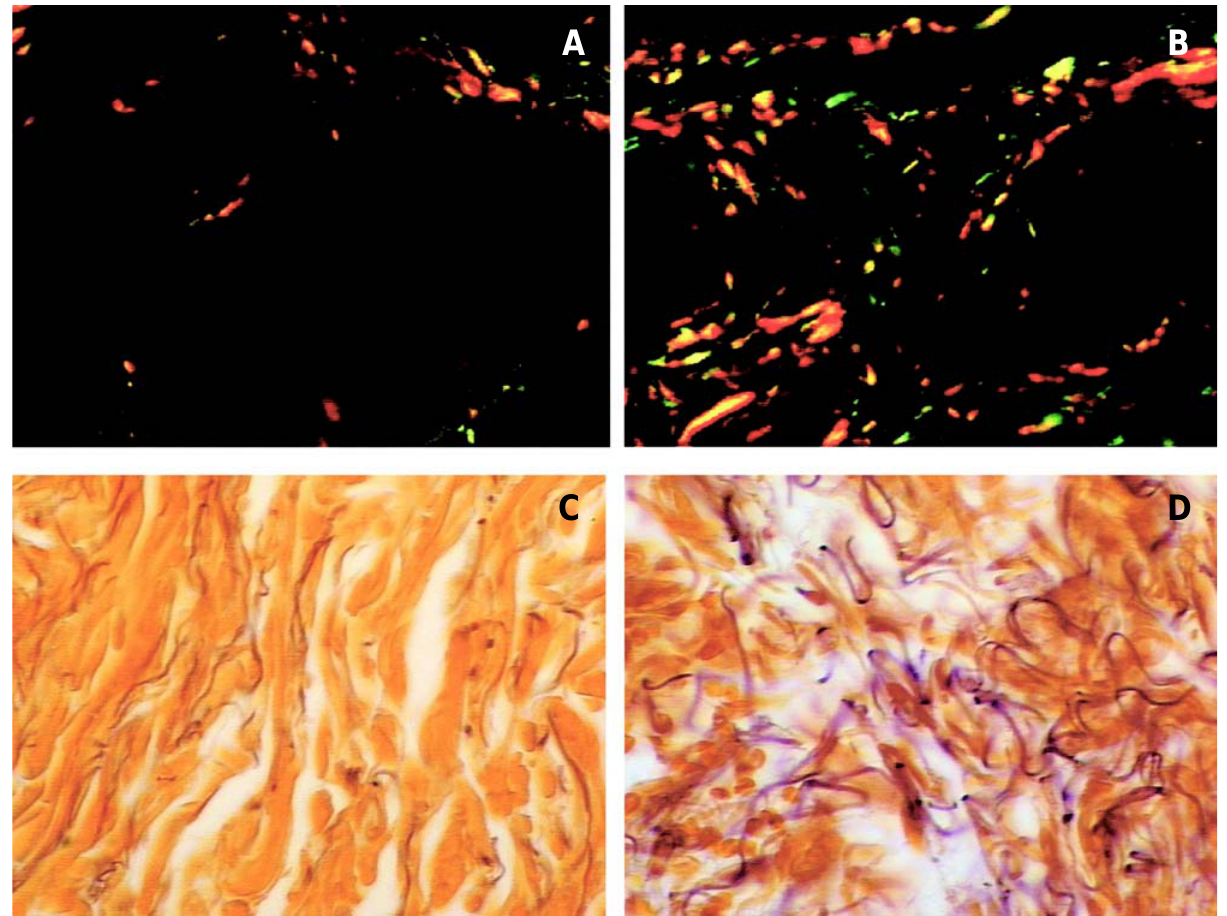
Figure 1 – Picro-Sirius-Red staining under polarization microscopy of the bladder wall demonstrating the amount of collagen in controls (A) and patients with bladder outlet obstruction (B), X400. Weigert’s Resorcin-Fucsin staining of the bladder demonstrating the amount of elastic system fibers in controls (C) and patients with bladder outlet obstruction (D),